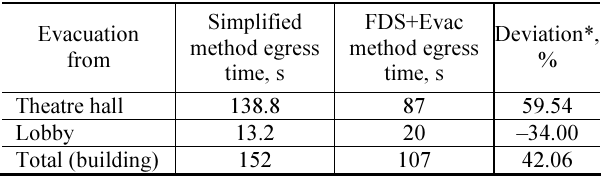
Table 3. The comparison of the egress times according to sim- plified and FDS+Evac methods